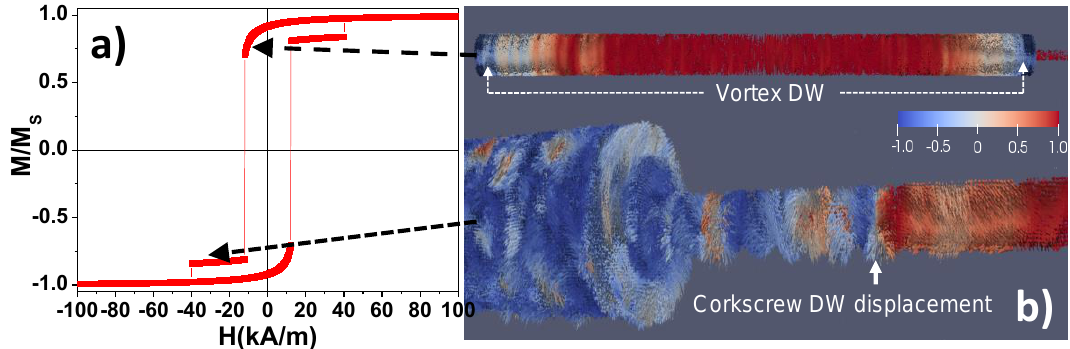
Figure 4. ( a ) Simulated hysteresis loop of sample WM9 showing a magnetization reversal with two Barkhausen jumps. ( b ) Micromagnetic simulation of the magnetic domain structure during the magnetization reversal of a bi-segmented diameter modulated FeNi nanowire at applied fields around 5.6 kA/m, showing the nucleation of two vortex DW at both ends of the wider segment that are propagating to the centre of the segment ( upper ); and the magnetic domain structure of the bi-segmented nanowire at applied fields around 38 kA/m, where the magnetic DW displacement for the magnetization reversal along the thinner segment of the FeNi nanowire, occurs via corkscrew movement ( lower ).